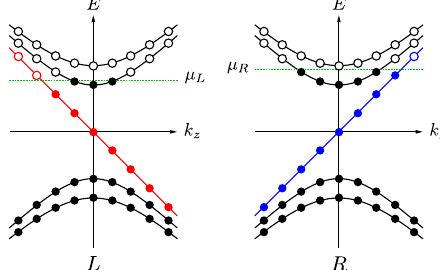
FIG. 2. Landau levels at Weyl nodes. Filled (empty) circles denote occupied (empty) LLs. Each node has nonchiral LLs that disperse parabolically in the field direction (here, ˆ z ) as well as a single chiral LL that disperses according to the node chirality (red and blue circles and lines). A chemical potential imbalance between the nodes leads to a net current flowing along the field, even for spatially uniform μ .